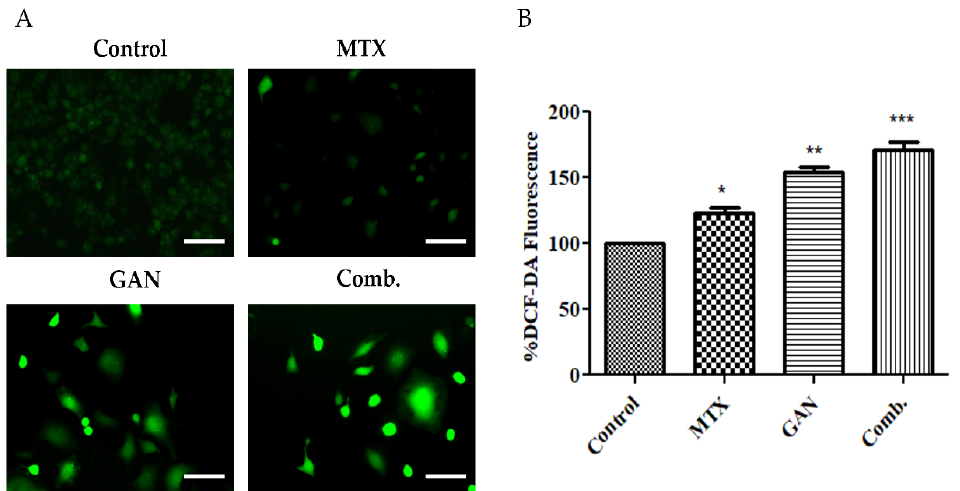
Figure 2. ( A ) ROS production in A549 cells with GAN and MTX alone or in combination compared to untreated control. ( B ) Quantification of augmented ROS in A549 cells after treatment with individual and combined doses of GAN and MTX compared to untreated control. Scale bar = 100 µm, Magnification: 20×. * p < 0.05, ** p < 0.01 and *** p < 0.001.